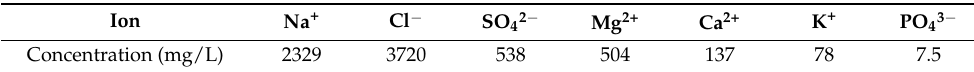
Table 2. The ions concentration in the Baltic Sea